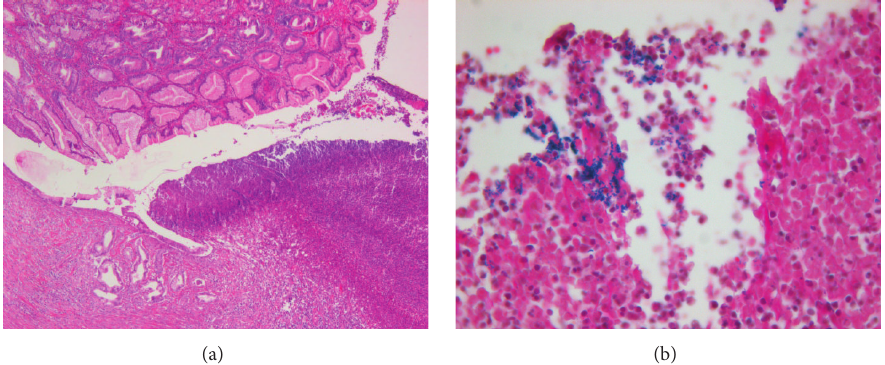
Figure 2: Histopathology of closure site (H&E, 50x). (a) Purulent exudate at site of closure, 10x. (b) Gram-positive staining at closure site,